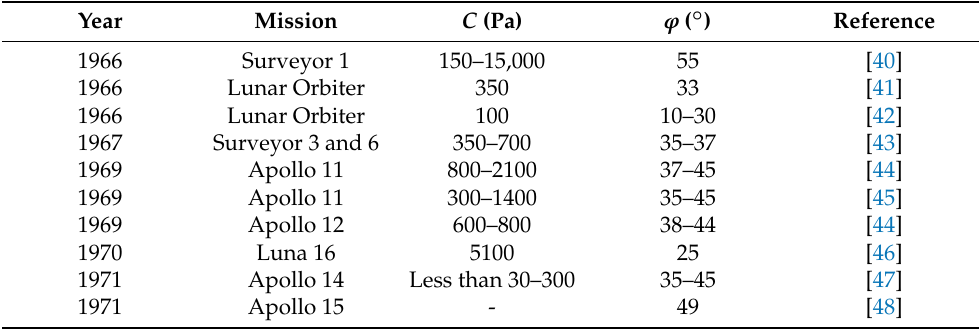
Table 1. Various sample-return missions and geotechnical characteristics of the lunar soils.